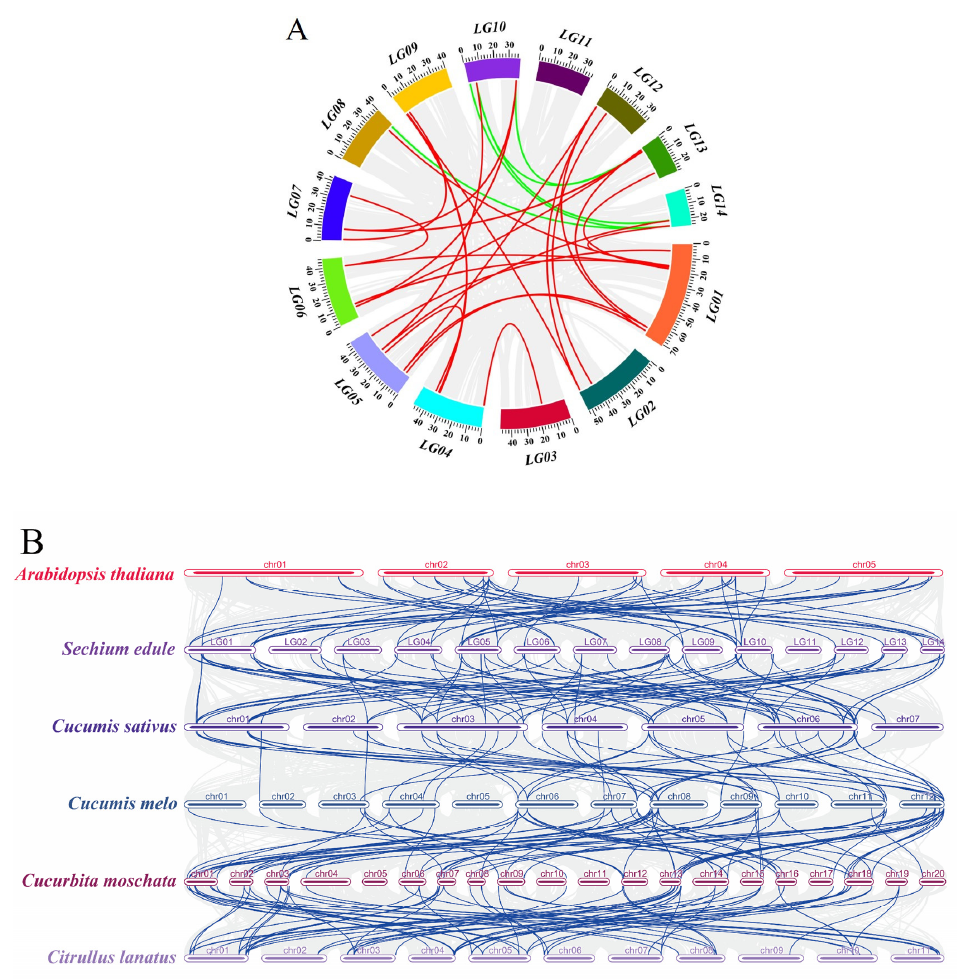
Figure 5. Collinearity analysis of MADS-box genes in S. edule and Arabidopsis . ( A ) Collinearity analysis of MADS-box genes in S. edule . The gray line represents all collinear regions in the genome of chayote, and the red line represents the collinear SeMADS-box in Se1-7; the green line represents the collinear SeMADS-box in Se8-14. ( B ) Synteny analysis of MADS-box genes between S. edule and Arabidopsis and species of Cucurbitaceae (cucumber, melon, pumpkin and watermelon). The blue line indicates SeMADS collinearity; the blue line indicates SeMADS-box collinearity.